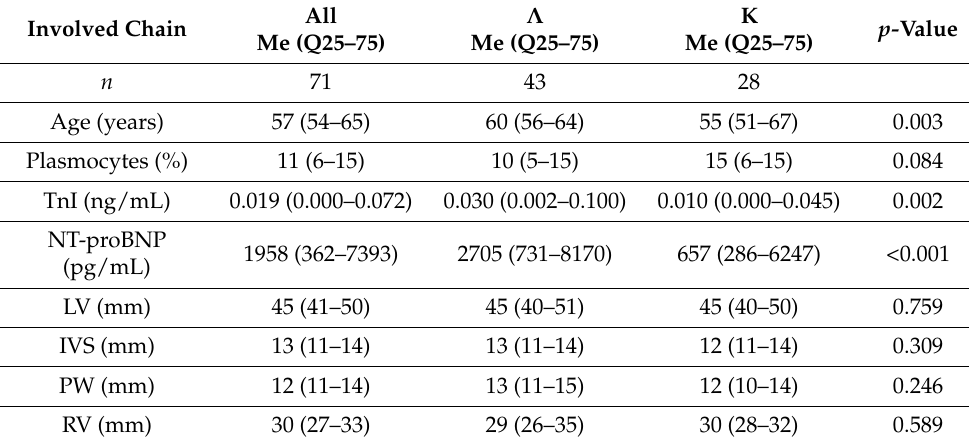
Table 3. Laboratory and clinical findings in enrolled subjects. The p -value concerns differences between groups of patients with λ and κ amyloid-forming light chains Involved